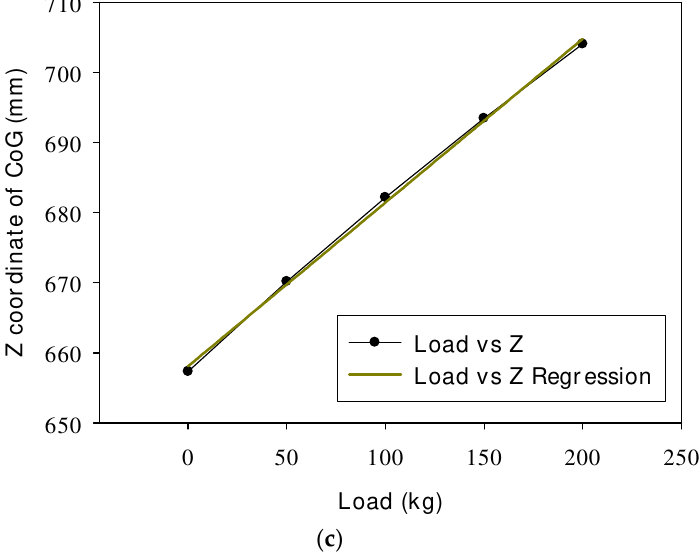
Figure 6. CoG deformations of cargo with loading conditions ( a ) X coordinate ( b ) Y coordinate ( c ) Z coordinate.